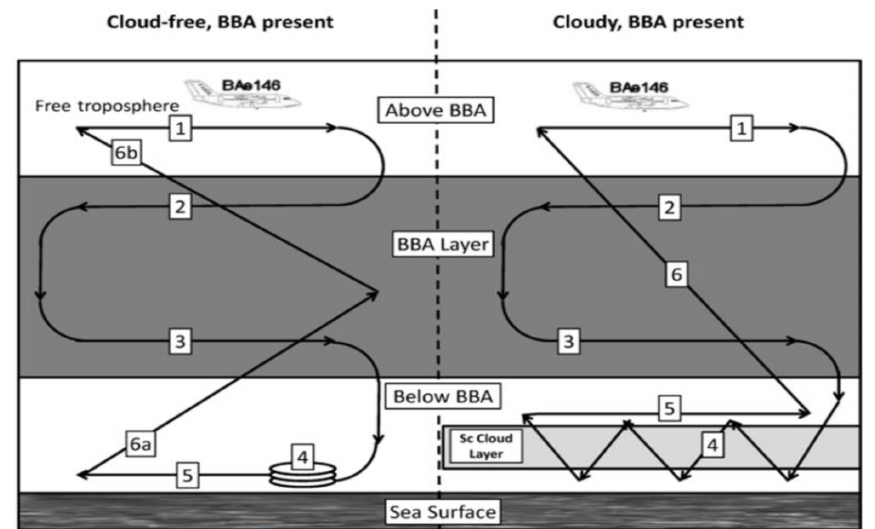
Figure 6. Schematic diagram of the manoeuvres that were typically performed during cloud-free and cloudy conditions. The numbers marked on the schematic represent the manoeuvres referred to in the